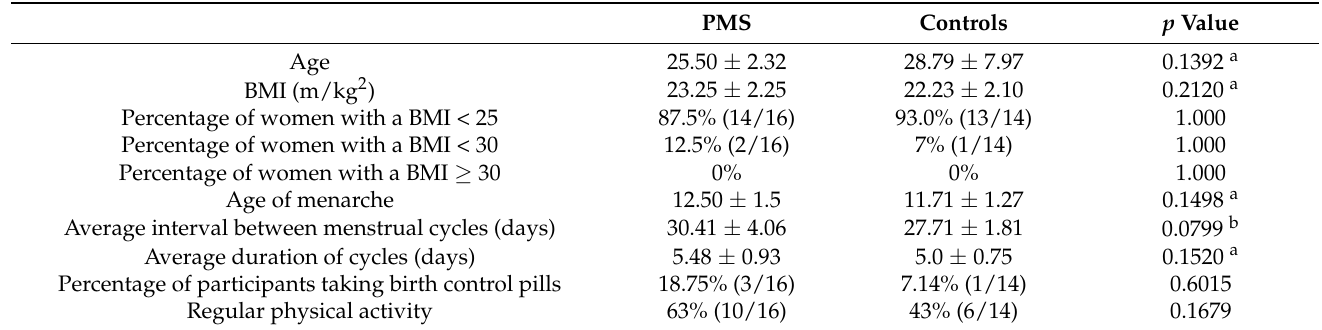
Table 1. Characteristics of the studied population.